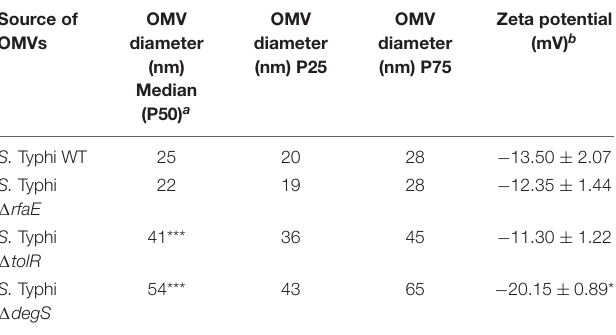
TABLE 1 | Some characteristics of OMVs used in this study. Source of